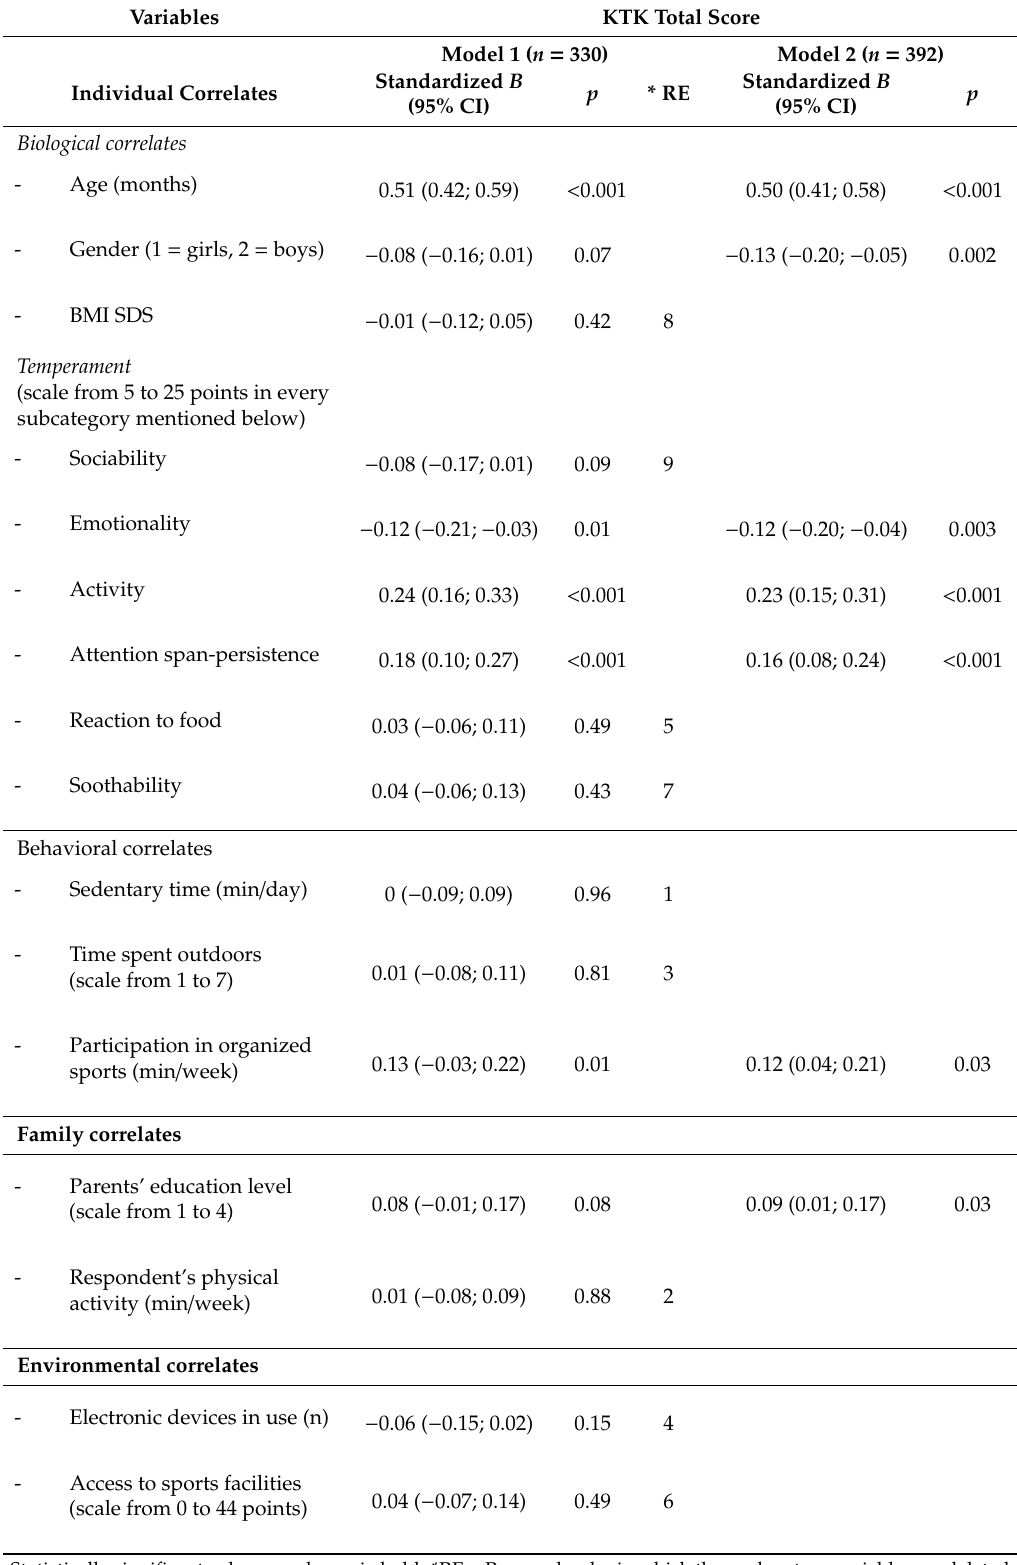
Table 3. Individual, family and environmental correlates associated with children’s KTK total